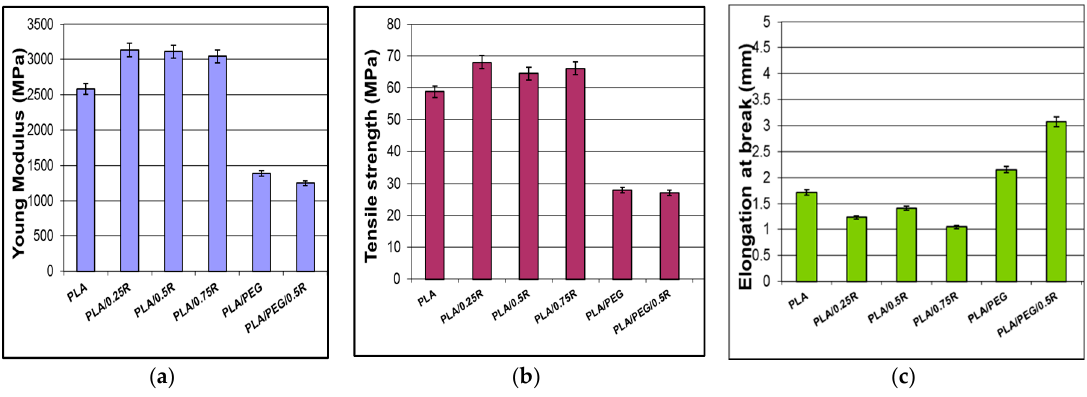
Figure 5. Mechanical properties of the PLA/R and PEG-plasticized PLA/R: ( a ) Young’s modulus; ( b ) tensile strength; ( c ) elongation at beak.